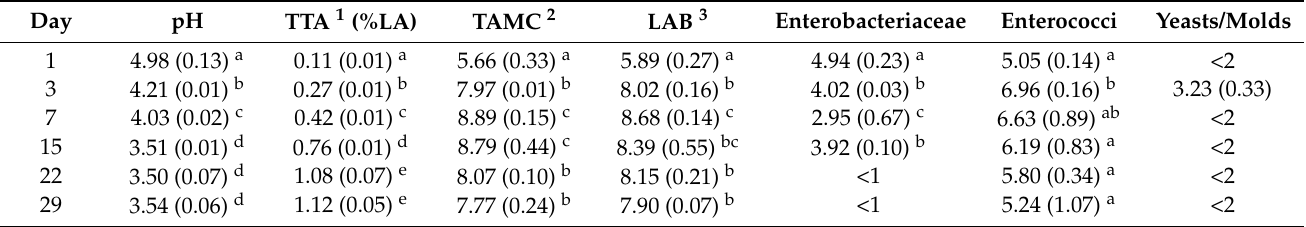
Table 1. Physicochemical and microbiological changes during spontaneous avyrtake fermentation.